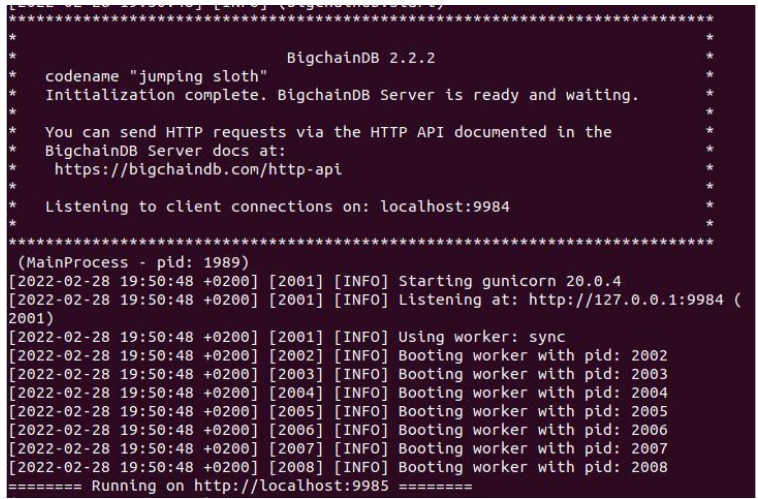
Figure 6. BigchainDB Server Activation.